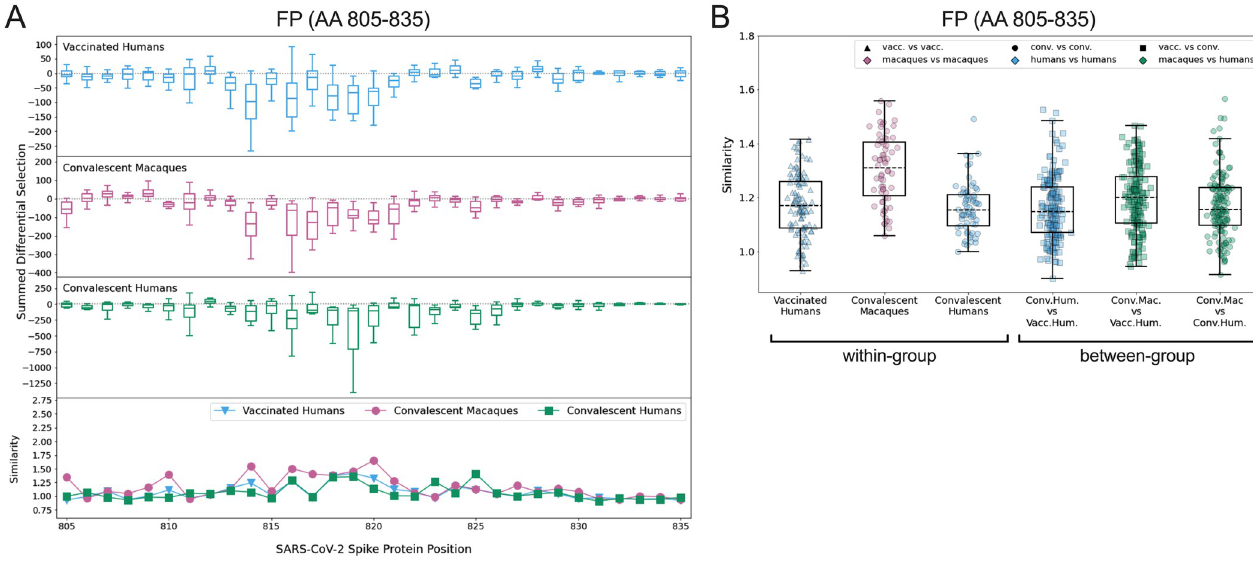
Fig 4. Comparison of escape profiles in the fusion peptide (FP). (A) and (B) Data are shown as described in Fig 3.